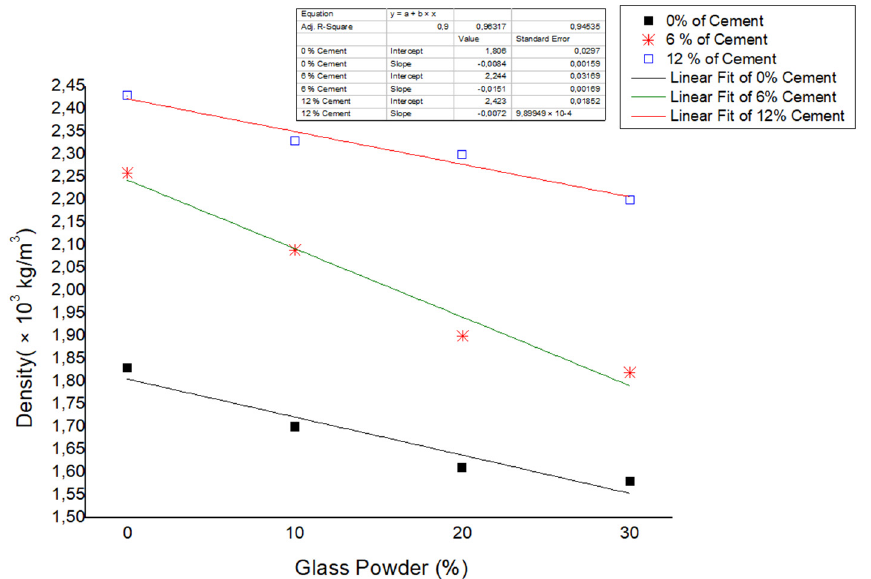
Figure 8. Variation of the measured bulk density in the dry state as a function of the glass powder content.